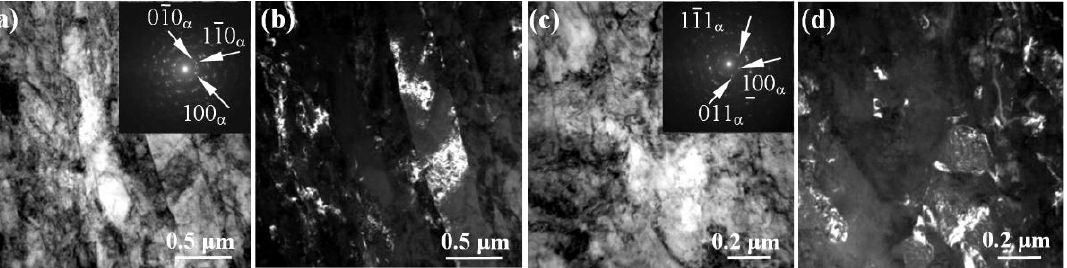
Figure 9. Microstructure of pure titanium in the UFG state before fracture in the neck area: ( a , c ) — the BF TEM images with the SAD patterns; ( c , d ) — the DF TEM images. Band structure with a cellular-network dislocation substructure ( a , b ), large anisotropic fragments with a cellular-network dislocation substructure ( c , d ).